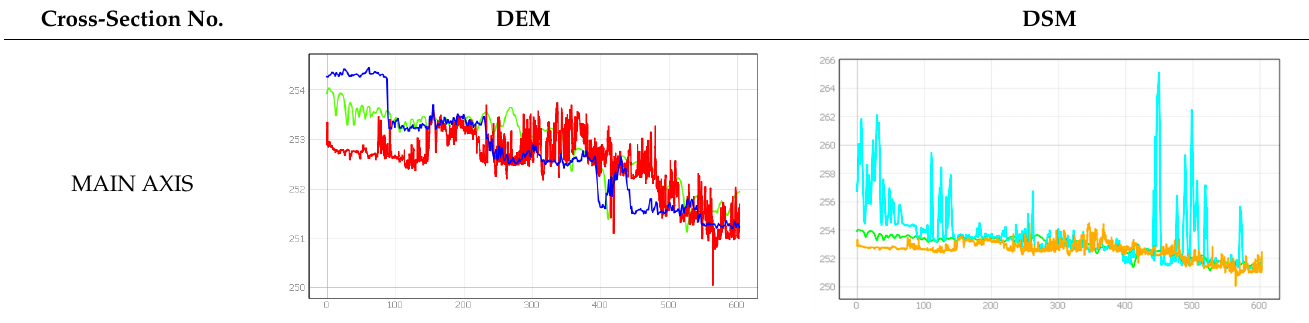
Table 5. Slope of land on cross-sections through watercourse bed on the DEM and DSM in raster form; source: own elaboration.